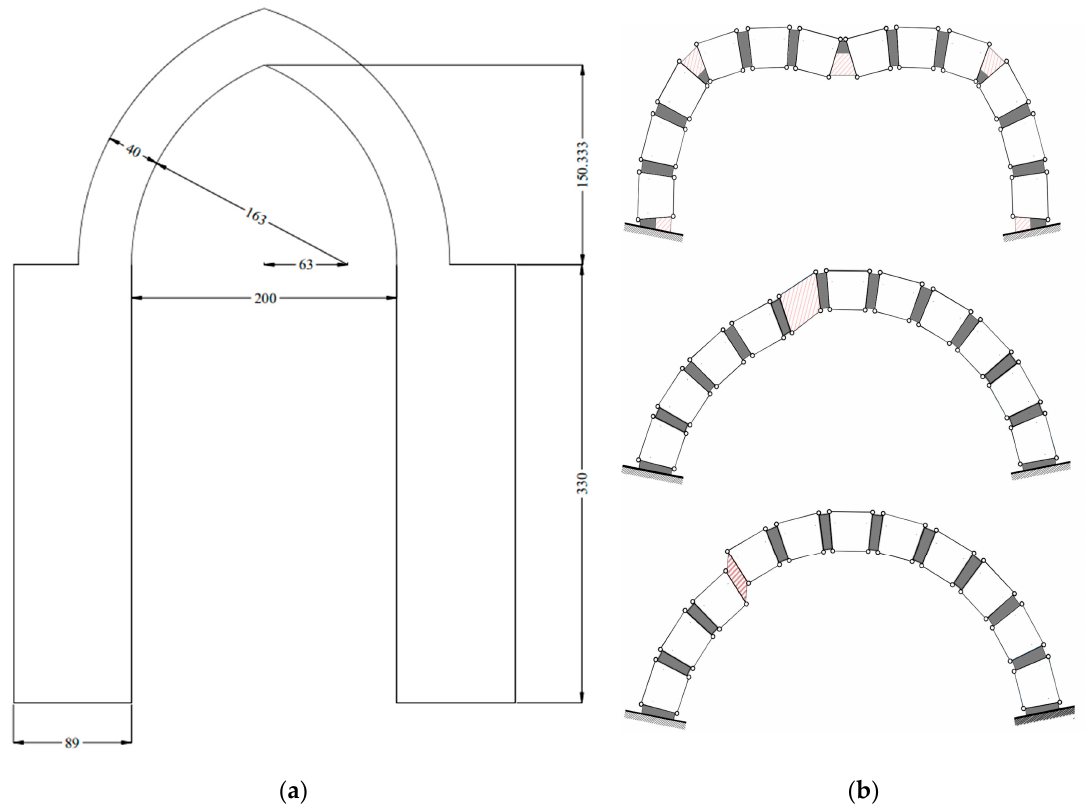
Figure 8. Validation of the automatic tool for limit analysis and comparison with DMEM: ( a ) layout of the system, and ( b ) typical failure modes of an arch [21]. Dimensions in cm. Adapted with permission from Ref. [21]. Copyright 2021 Elsevier.